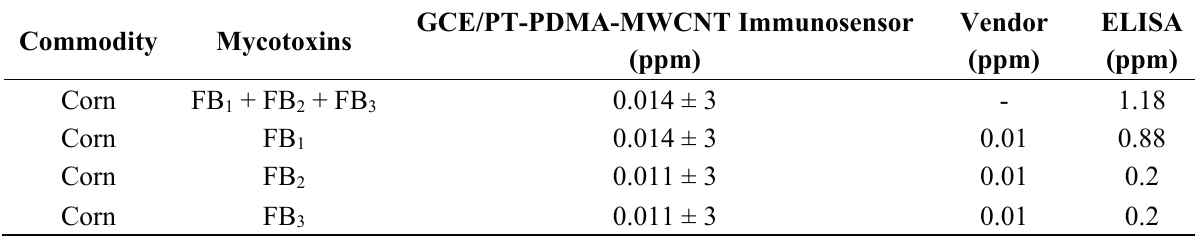
Table 1. Fumonisins content of corn certified reference